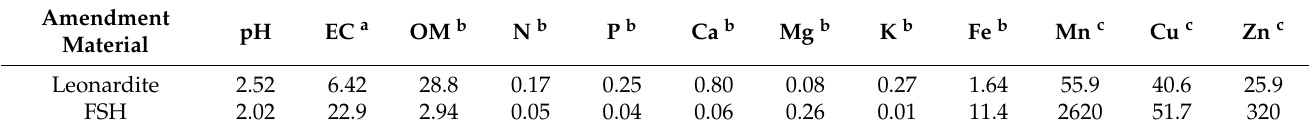
Table 8. Characteristics of the leonardite and ferrous sulphate heptahydrate (FSH) materials expressed on a dry-matter basis. a Electrical conductivity (EC) in dS/m; b organic matter (OM), N, P, Ca, Mg, K, and Fe in %; c Mn, Cu, and Zn in mg/kg (n = 3).